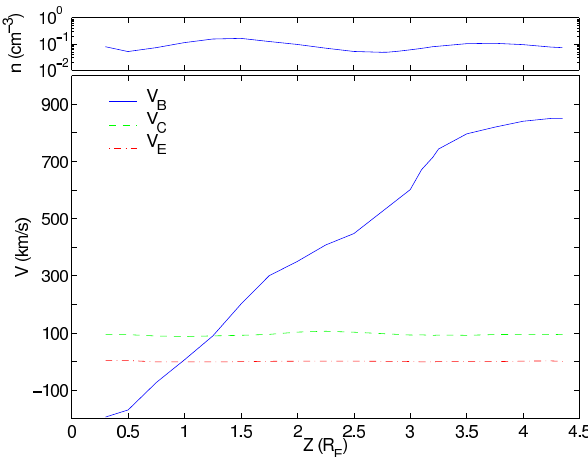
Fig. 13. Model (top) number density and (bottom) velocity mo- ments calculated at various Z -distances from the NS at X =-20 R E . The velocities are expressed in terms of the directions of the mag- netic field ( V B ), electric field ( V E ) and convection ( V C